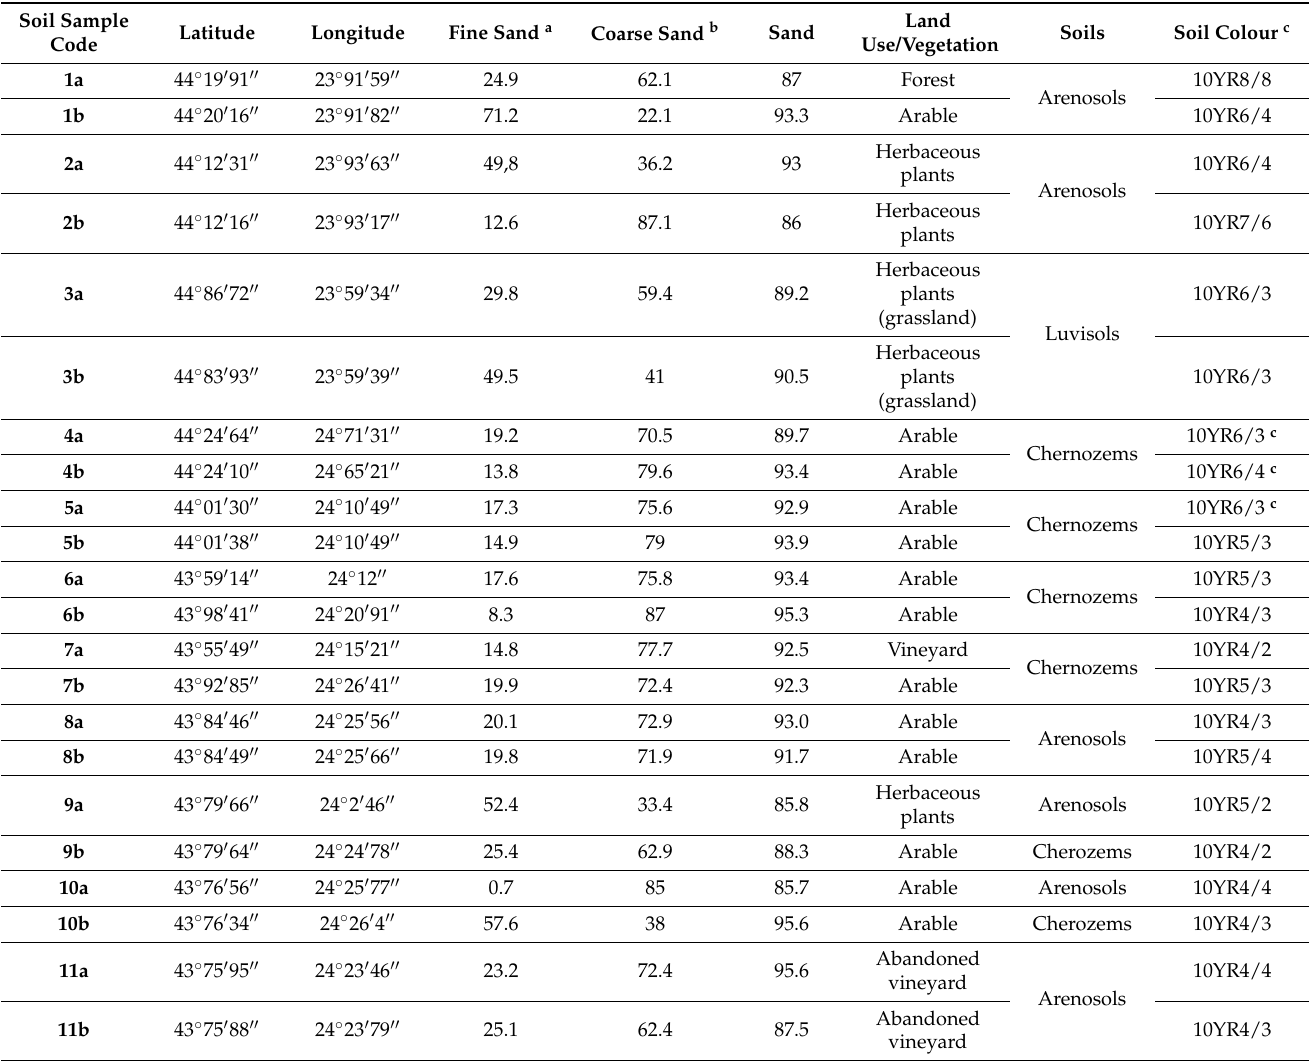
Table 7. Soil properties and land